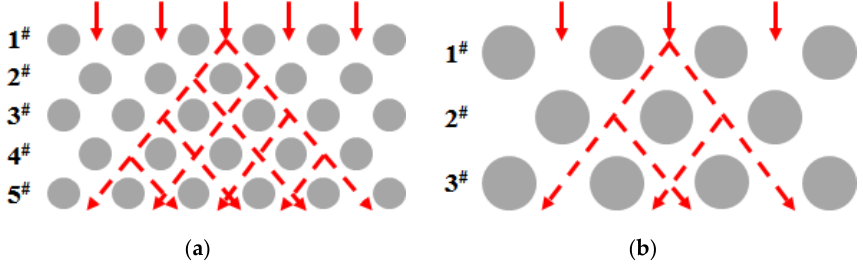
Figure 9. Schematic diagram of structures of porous media: ( a ) small pore sizes, ( b ) large pore